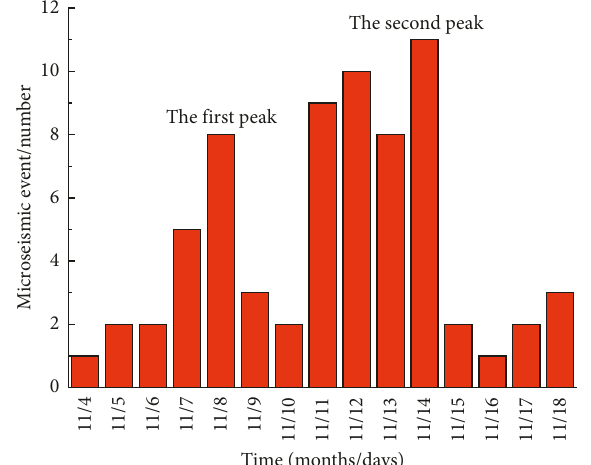
Figure 6: The evolution of the number of microseismic events with time during the large-scale deformation and failure of the soft